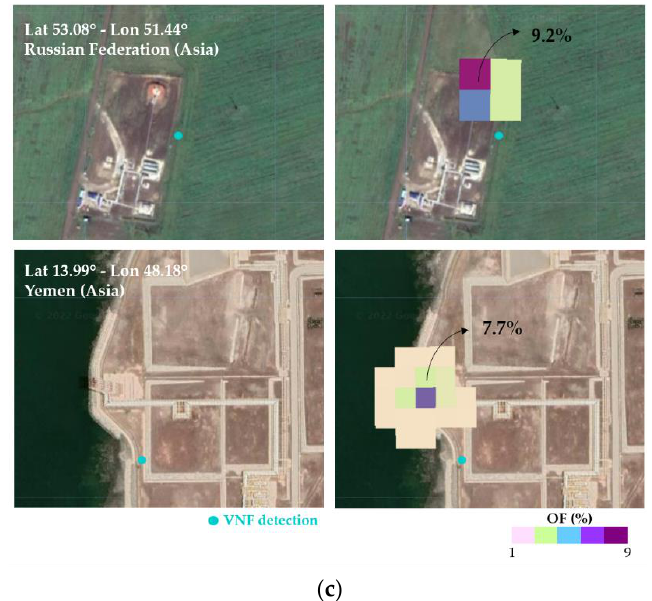
Figure 12. Some examples of gas flares: ( a ) identified by DAFI, not by VNF; ( b ) identified by both; ( c ) identified by VNF, not by DAFI (because of OF < 10%).